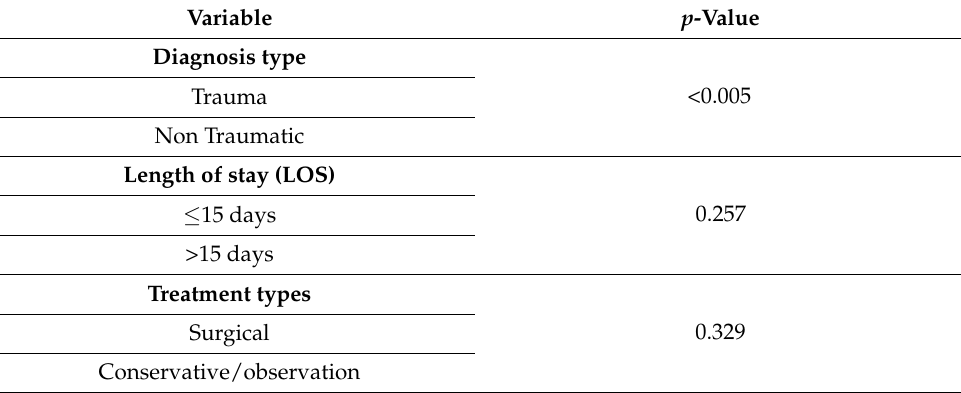
Table 2. The association between the age group (more and less than 75 years) and other variables.